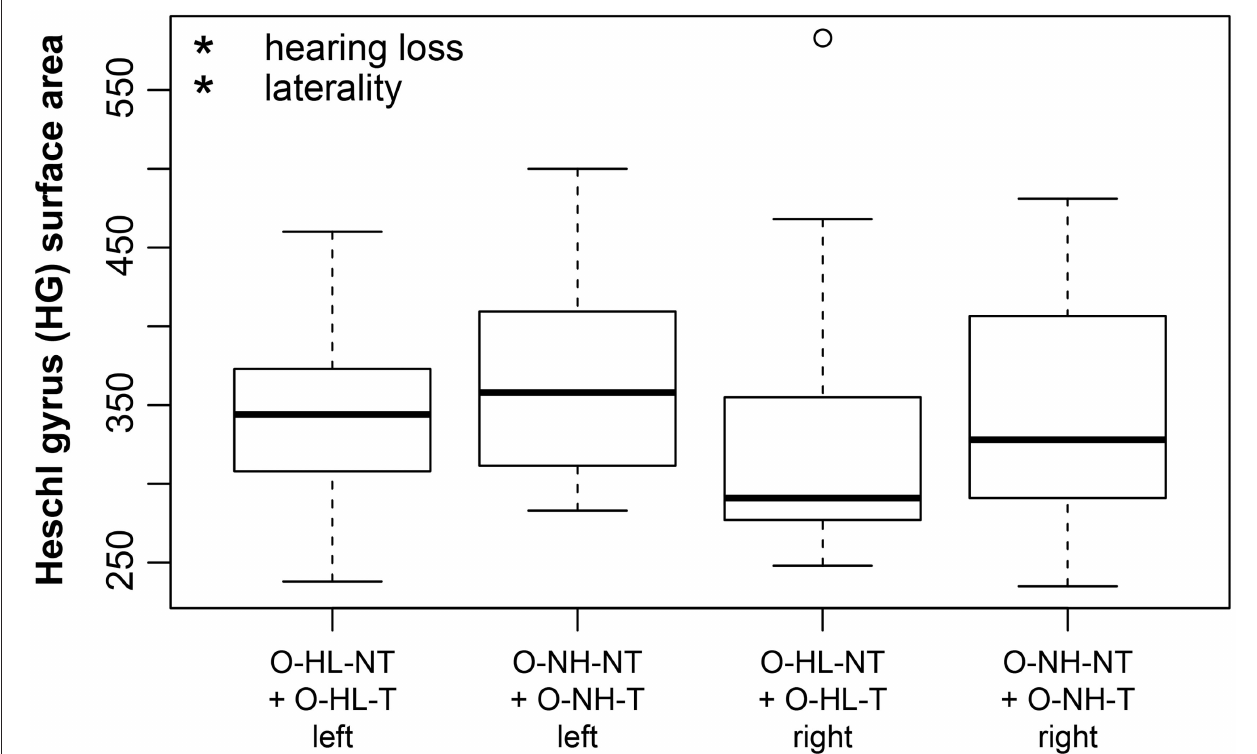
FIGURE 5 | Cortical surface area is decreased due to hearing loss in HG (apparent when groups with mild and expressed presbycusis are compared). HG surface area is larger on the left side (laterality). The effect of hearing loss on surface area of HG is independent of the laterality. Only data from aged groups are used and are pooled together based on the degree of presbycusis; right and left include data from right and left HG. Data are compared based on M3 (only elderly groups). * p < 0.05